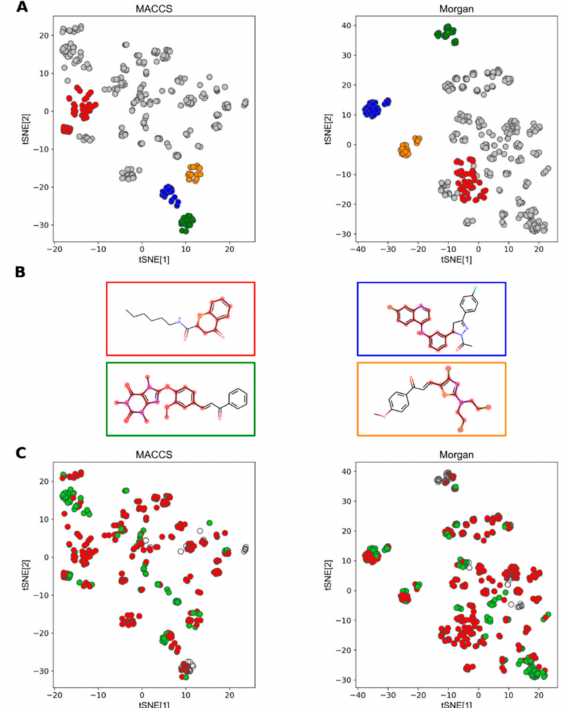
Figure 7. Representation of the chemical space of compounds tested against intracellular amastigotes of L. panamensis . ( A ) t-distributed Stochastic Neighbor Embedding (t-SNE) plot showing four common clusters to Molecular ACCess System (MACCS) (left) and Morgan (right) fingerprints, highlighted by red, blue, orange and dark green dots. Light gray dots represent the rest of the compounds. ( B ) Chemical structures of representative compounds of each selected cluster (enclosed in boxes colored according to the previous plot) with maximum common substructure (MCS) highlighted by pink contours. ( C ) t-SNE plot with dots colored by activity. Green dots: active compounds (pEC 50 ≥ 5), red dots: intermediate and poorly active compounds (pEC 50 < 5), empty dots: compounds without EC 50